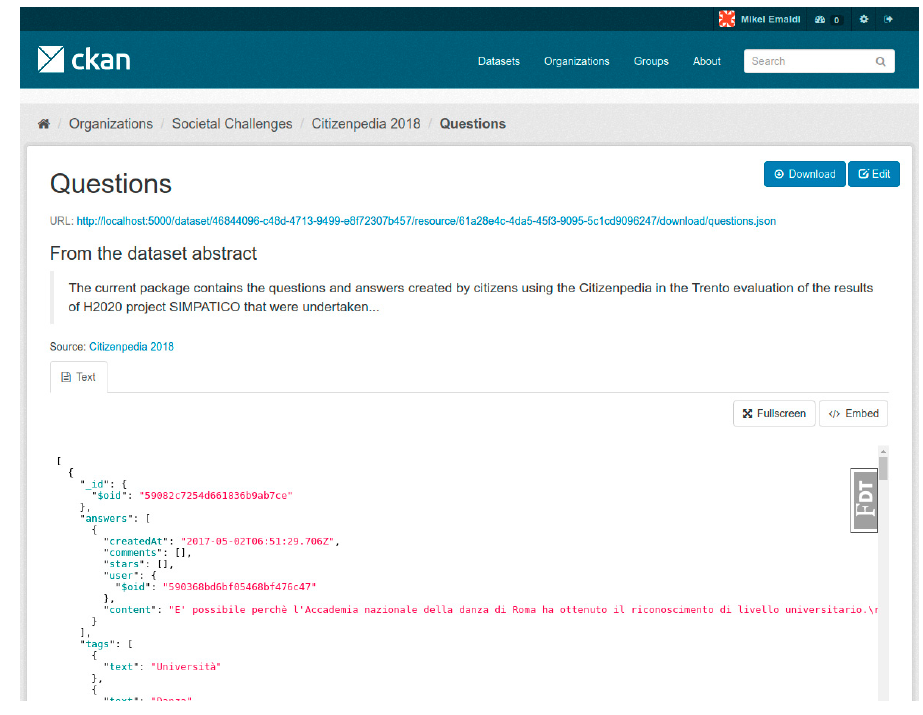
Figure 4. Dataset description in CKAN.